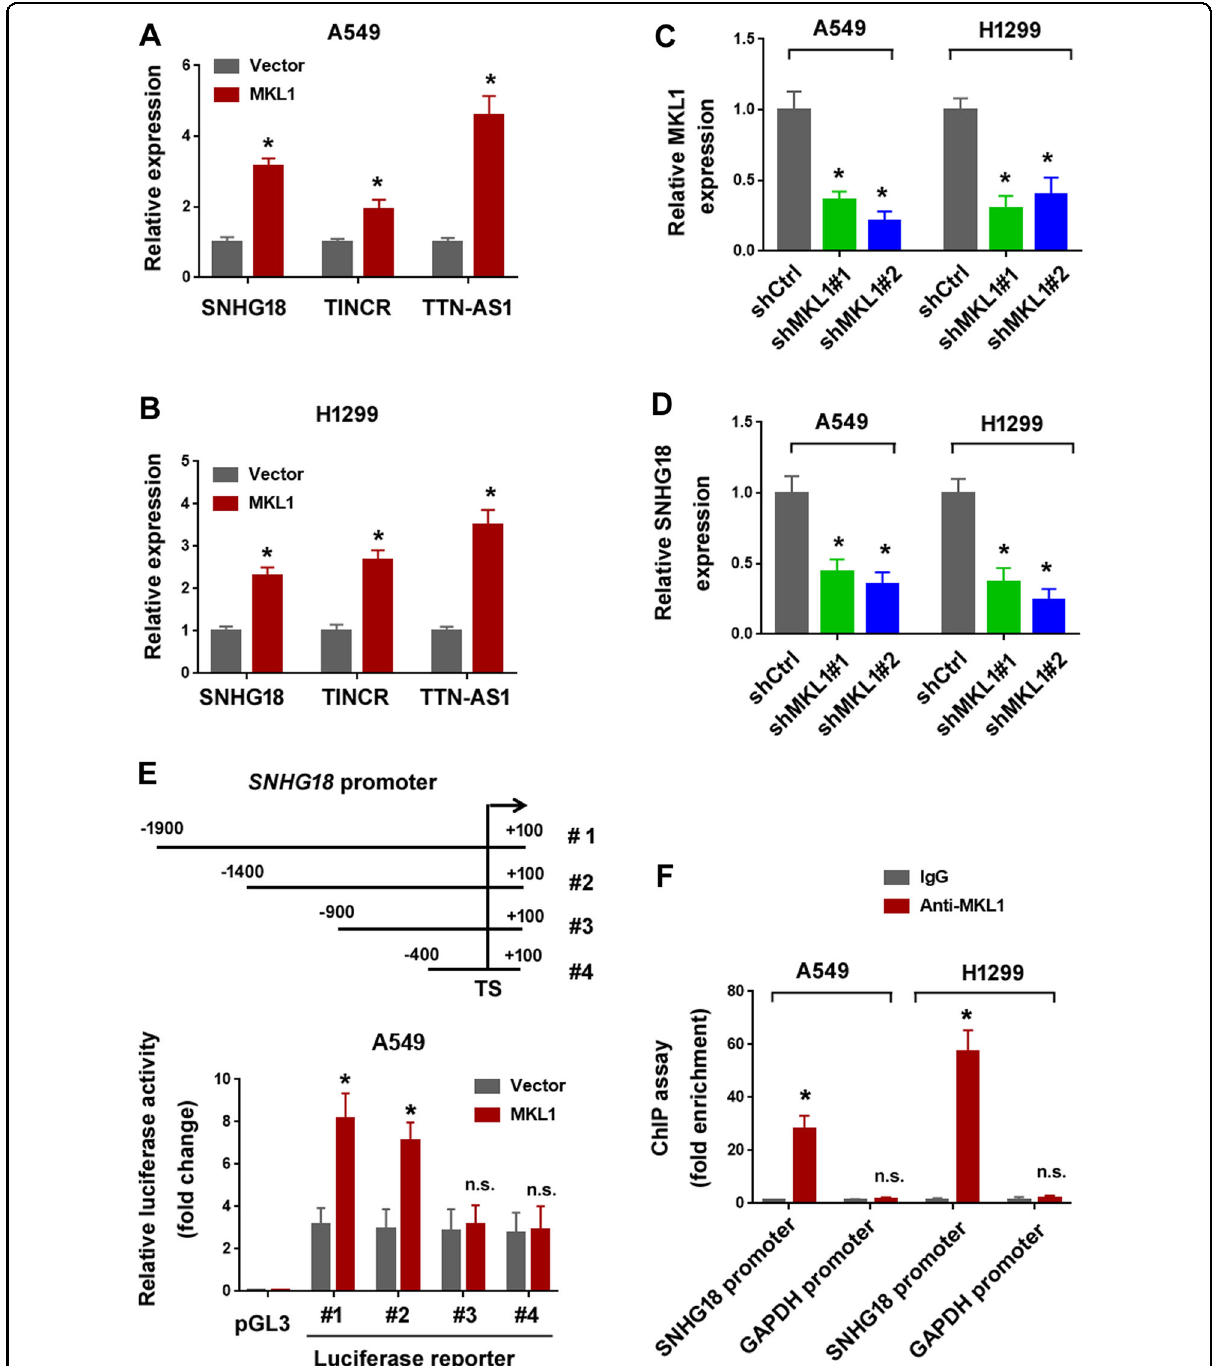
Fig. 1 SNHG18 is transactivated by MKL1 in NSCLC cells. A , B Quantitative PCR analysis of indicated lncRNAs in A A549 and B H1299 cells transfected with empty vector or MKL1-expressing vector. * P < 0.05 vs . vector, Student ’ s t -test. n = 3. C Quantitative PCR analysis of MKL1 mRNA in NSCLC cells transfected with negative control shRNA (shCtrl) or 2 different shRNAs targeting MKL1 (shMKL1#1 and shMKL1#2). * P < 0.05 vs. shCtr, one- way ANOVA followed by Bonferroni ’ s test. n = 3. D Quantitative PCR analysis of SNHG18 expression in MKL1 shRNA-transfected NSCLC cells. * P < 0.05 vs. shCtr, one-way ANOVA followed by Bonferroni ’ s test. n = 3. E A549 cells were transfected with SNHG18 promoter reporters together with MKL1- expressing vector, and luciferase activities were measured 24 h after transfection. * P < 0.05 vs. vector, Student ’ s t - test. n.s. indicates no signi fi cance rela t ive to vector. n = 3. F ChIP assay showed the occupancy of MKL1 protein on the promoter of SNHG18 ( − 1269 to − 1072 bp) but not GAPDH ( − 781 to − 435 bp). * P < 0.05 vs. control IgG, Student ’ s t -test. n.s. indicates no signi fi cance relative to control IgG. n =